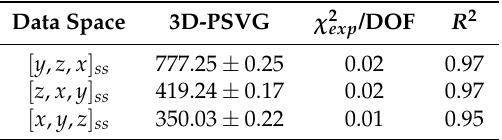
Table 1. Comparison of 3D-PSVG values and other relevant details calculated for the 3 data